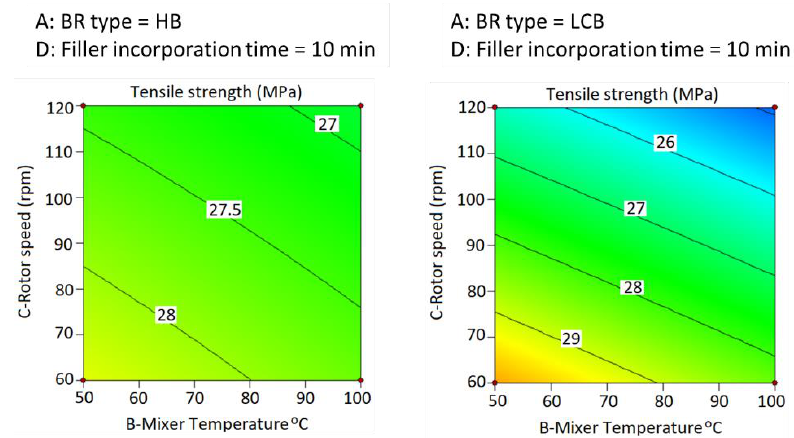
Figure 11. The effect of mixer temperature and rotor speed on the tensile strength in rubber compounds containing HL-BR and LCB-BR.